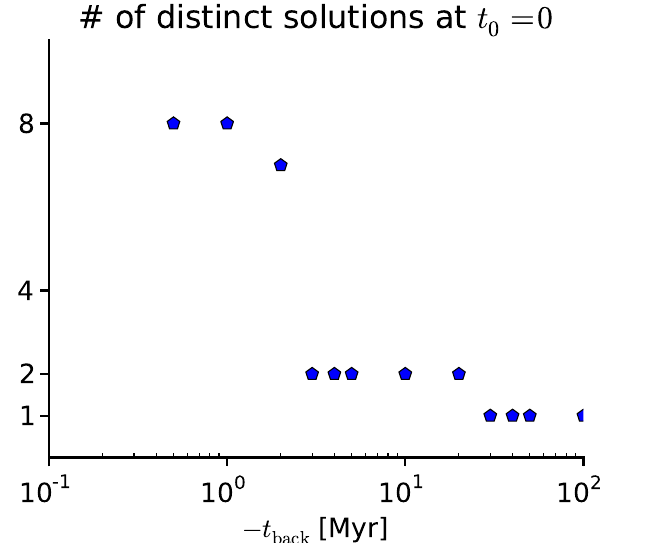
Fig. 12. As Fig. 8 but with: F(t) = γ( sin ( 2 π/P 2 t + φ P 2 ) + sin ( 2 π/P 3 t + φ P 3 )) . Hashes indicate regions of Rayleigh number > 0 . 95 on the beating associated with P 2 and P 3 , the period of which is called E 3 in the Berger (1978) nomenclature (third com- ponent of